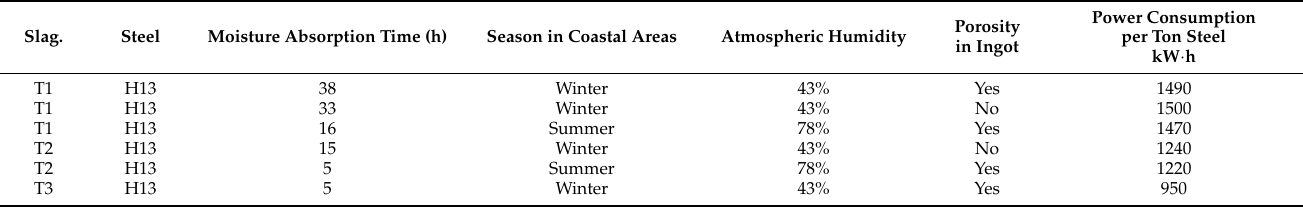
Table 5. Porosity defects in ingots during ESR process under different seasons and slag system. Slag.